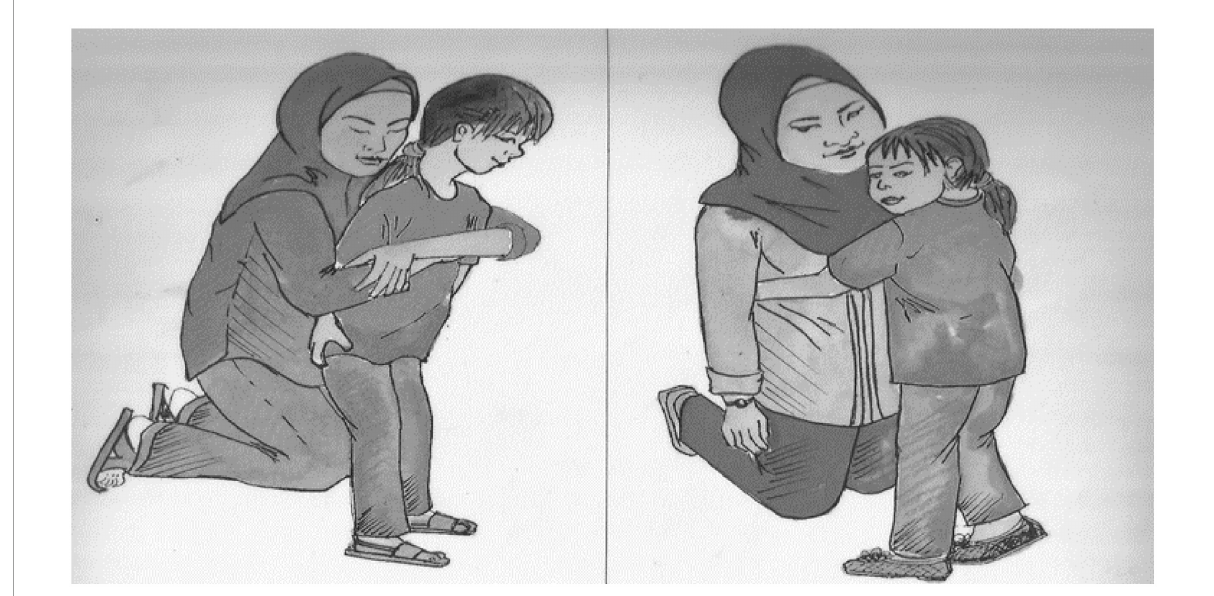
FIGURE1 Picture pair used for the sentence “ Emak mana yang adik peluk ?” ( Which mother is little daughter hugging?